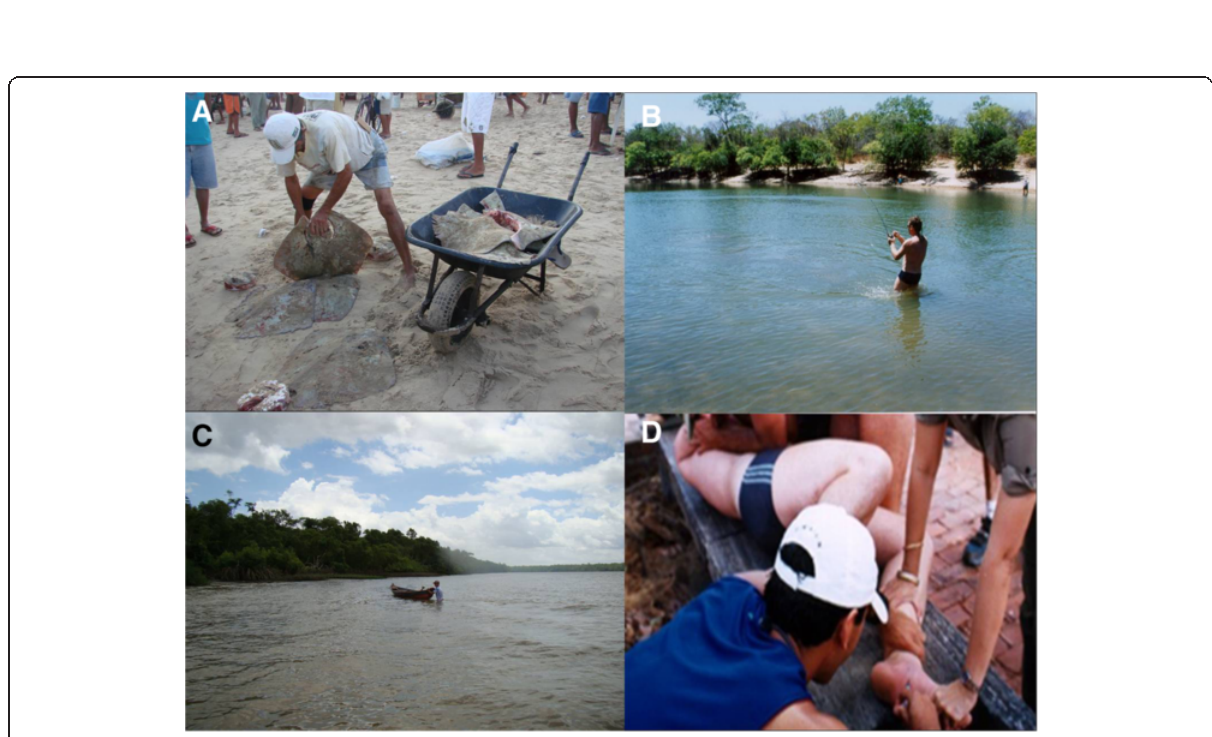
Figure 4 Environments with high risk of injuries by stingrays. (A) A fisherman handling marine stingrays in a fish market. (B) An amateur fisherman was fishing in a tributary of the Araguaia River (Midwest region of Brazil) when he was injured by a freshwater stingray. (C) A fisherman pushes his boat into shallow waters of a tributary of the Amazon River where rays are common: the risk of envenomation is high. (D) The pain of the man in (B) was excruciating. Photos by: Vidal Haddad Junior and Luís Fernando Beretta